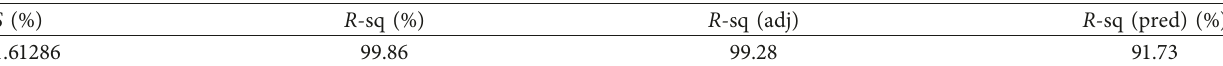
Table 12: Model summary.